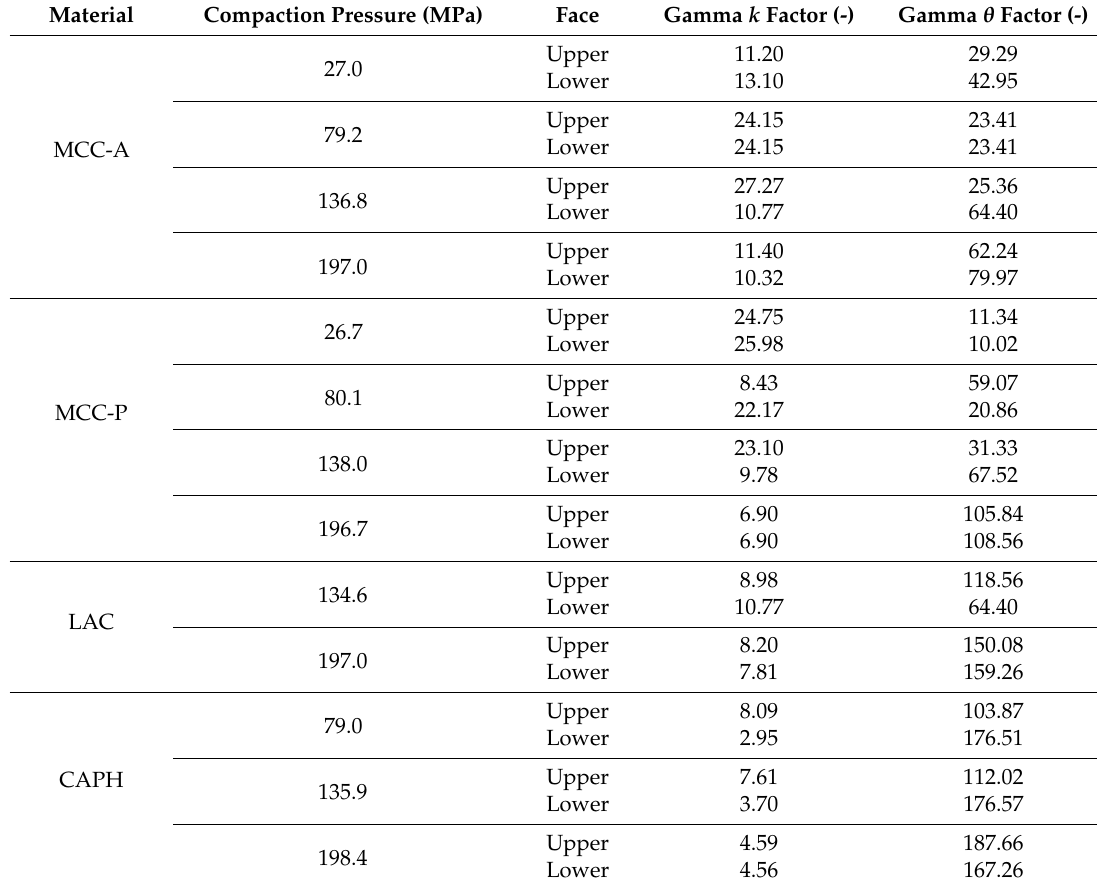
Table 2. Fitting volumetric/weight cumulative parameters for gamma distributions ( Q 0 ) as a function of the maximum compaction pressure for the upper and lower tablet